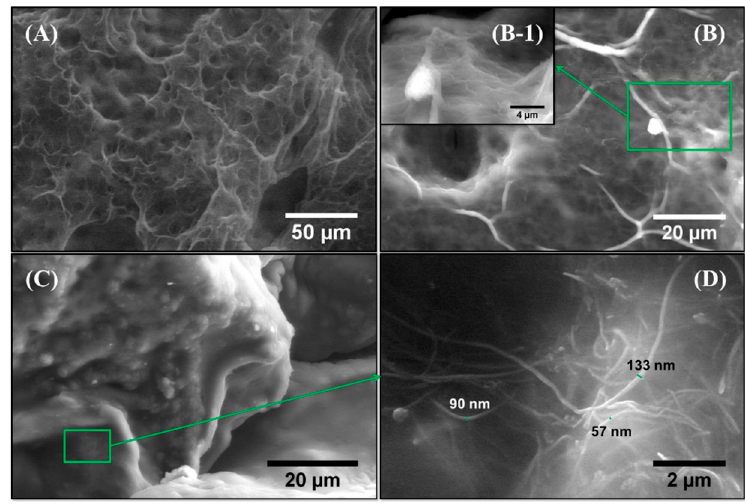
Figure 3. Scanning electron micrographs of freeze-dried hydrogels: ( A ) swollen PAA-co-IA/NaOH, ( B ) swollen PAA-co-IA/NaOH/B-MWCNTs (within an approach ( B-1 )), ( C ) dry PAA-co-IA/NaOH/B-MWCNTs, and ( D ) an enlargement of the area bounded by the rectangle.